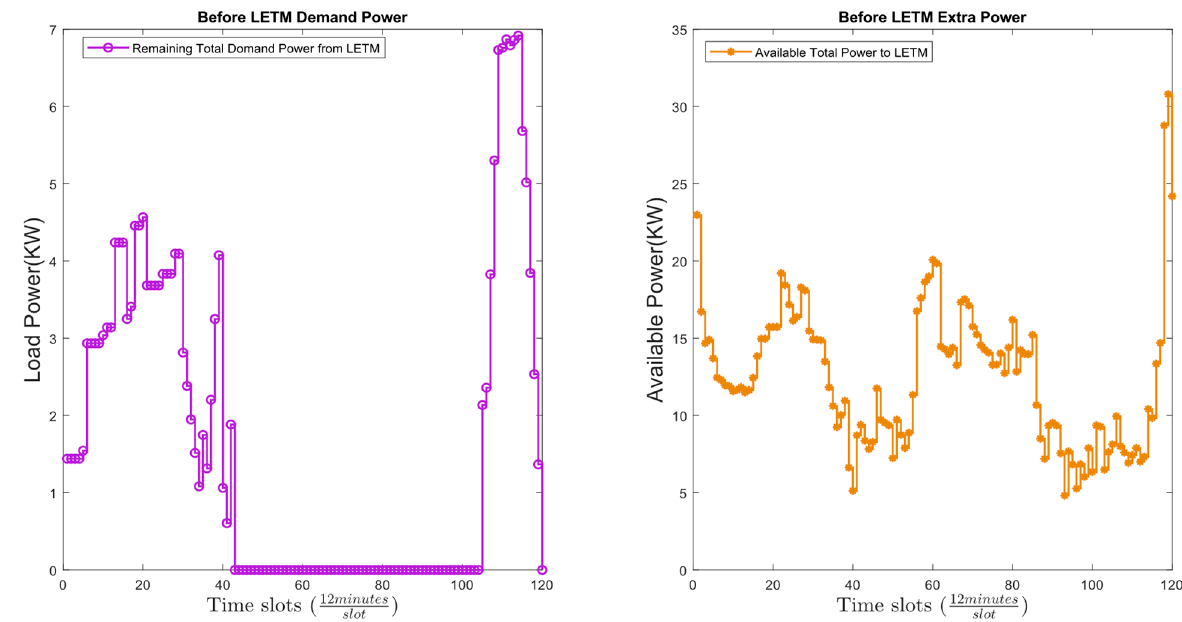
Figure 26. Power demand and surplus before LETM network for scheduled load in scenario 3.